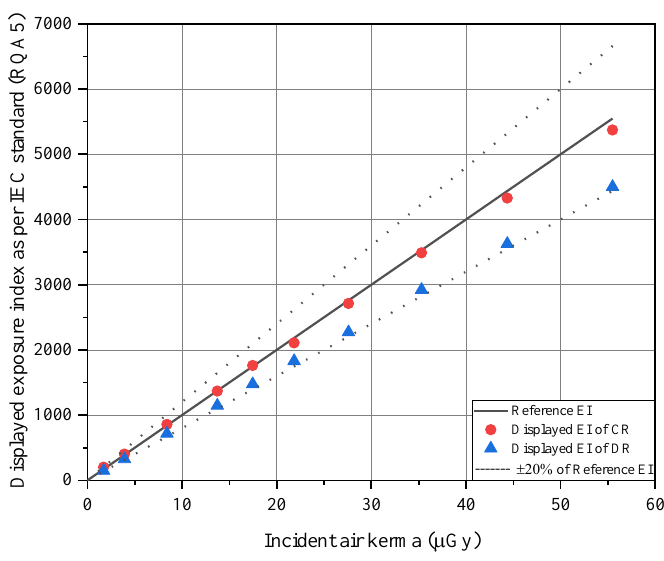
Figure 4. Relationship between reference EI and displayed EI.